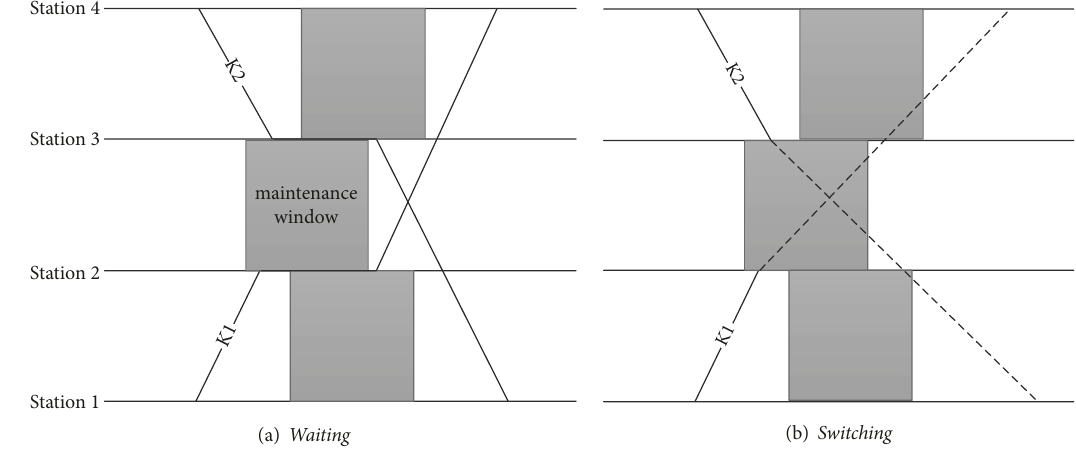
Figure 3: Illustration of SDSA-trains operation